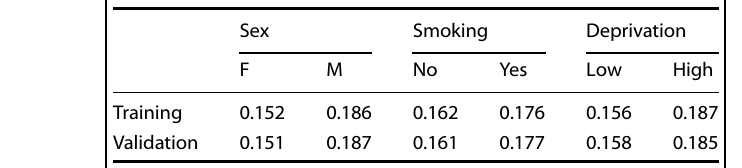
Table 1. Strati fi ed model performance to demonstrate inequity. NRMSE is shown across three example